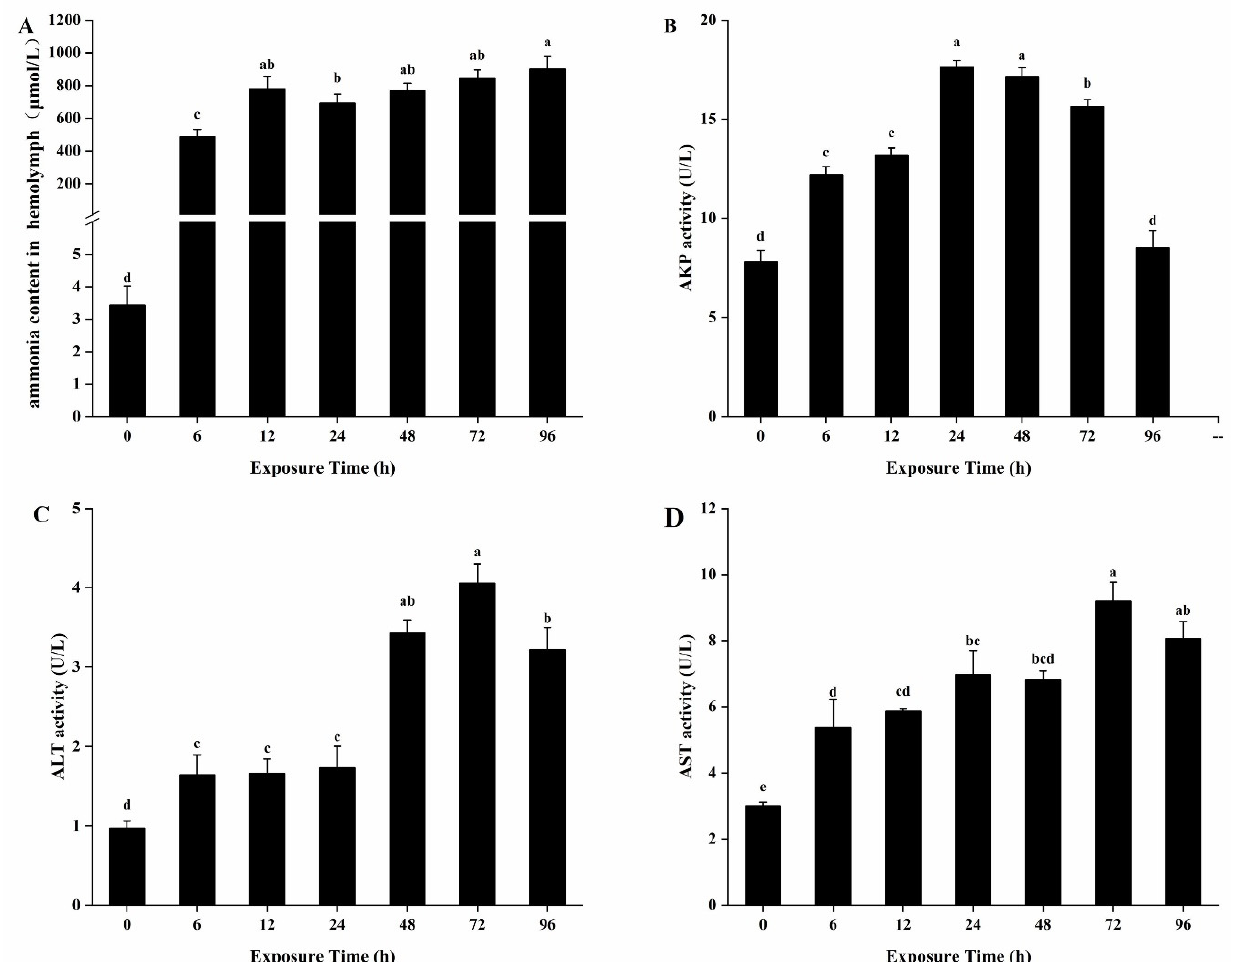
Figure 1. The contents of ammonia in the hemolymph ( A ), and the activities of AKP ( B ), ALT ( C ), and AST ( D ) in the hemolymph of H. cumingii exposed to 6.43 mg L − 1 unionized ammonium for 0 (control), 6, 12, 24, 48, 72, and 96 h. Values are presented as the mean ± SE ( n = 6). Superscripted lowercase letters indicate a significant effect of exposure time ( p < 0.05).